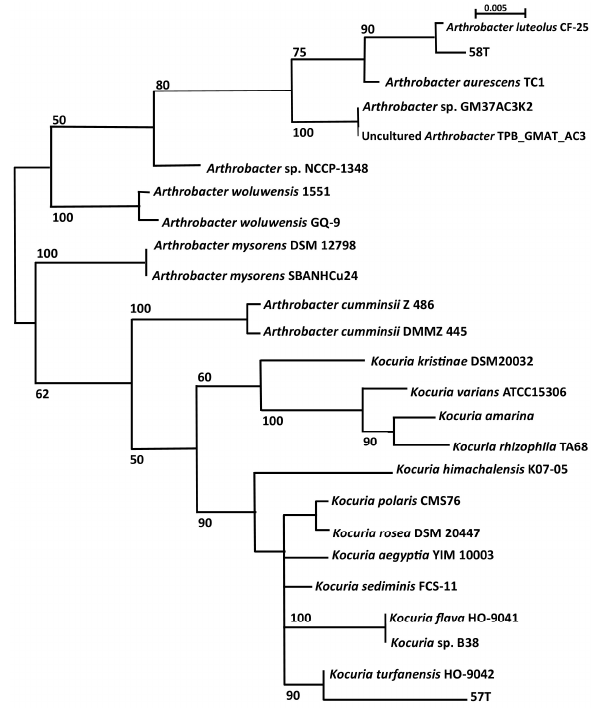
Figure 3. Unrooted parsimony tree for Actinobacteria showing the placement of isolate 57T with Kocuria and isolate 58T with Arthrobacter with bootstrap values.